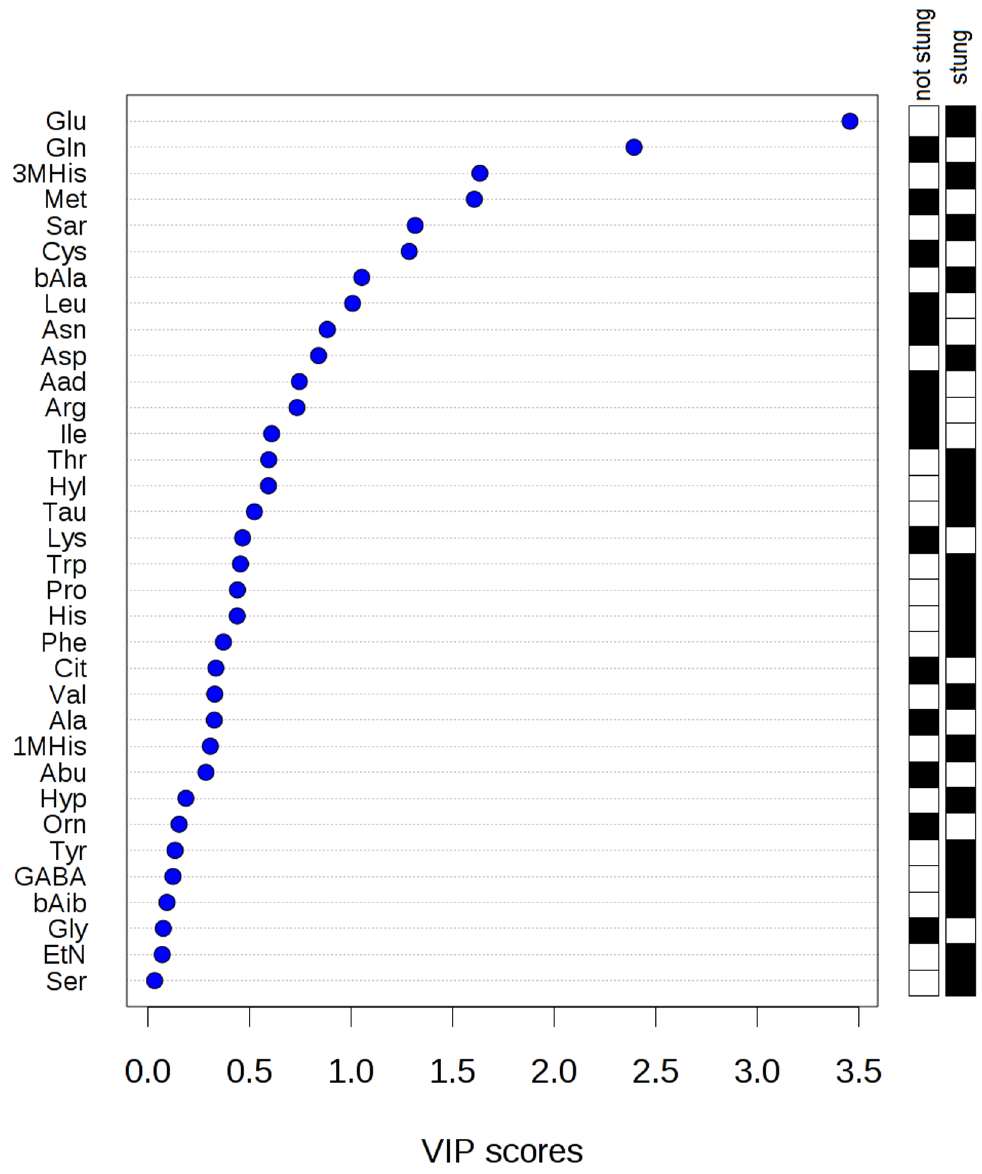
Figure 3. Variable importance in projection (VIP) plot: important features (analyzed serum free amino acids) identified by PLS-DA in a descending order of importance. The graph represents relative contribution of amino acids to the variance between the stung and non- stung individuals. High value of VIP score indicates great contribution of the amino acids to the group separation. The black and white boxes on the right indicate whether the metabolite concentration is increased (black) or decreased (white) in the serum of the stung vs. non-stung beekeepers. doi:10.1371/journal.pone.0103533.g003 two analyzed groups of beekeepers. In a ROC curve, the true positive rate (sensitivity) is plotted against the false positive rate (1- specificity) for different cut-off points of a given parameter. The test, which can perfectly distinguish between two diagnostic groups, has a ROC curve that passes through the upper left corner of the plot (100% sensitivity, 100% specificity). Thus, the closer the ROC curve is to the upper left corner, the better diagnostic power of the test is achieved. In turn, the closer the ROC curve to the diagonal line, the poorer accuracy of the test. ROC curve is using non-parametric algorithms so there is no need to perform data normalization.